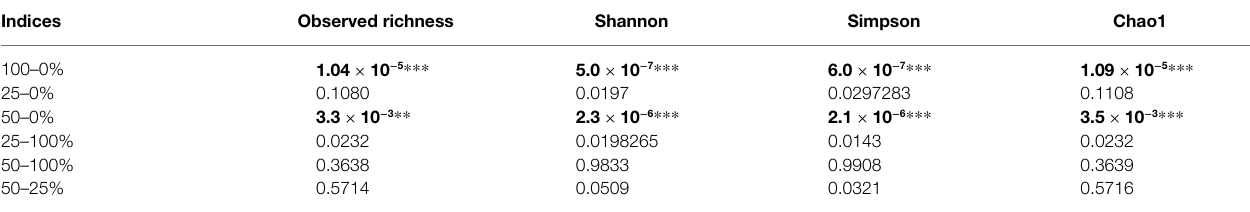
TABLE 2 | Value of p for fertilization rates estimated from observed richness, Shannon index, Simpson index and Chao1 index values.